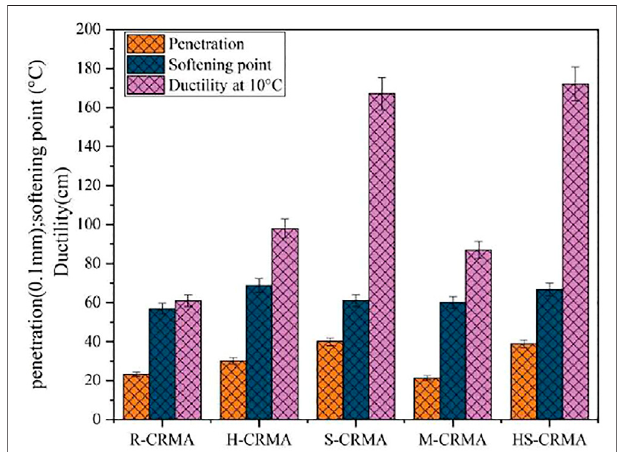
FIGURE 3 | The basic physical properties of asphalt with various activated CR